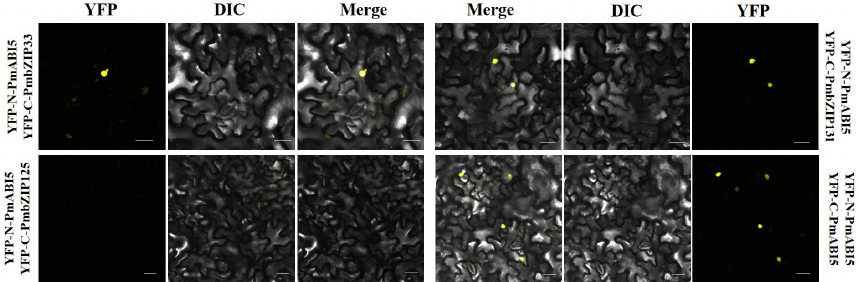
Figure 7. Bimolecular fluorescence complementation of PmbZIPs . Yellow color indicates YFP signal. Scale bars = 50 μ M.